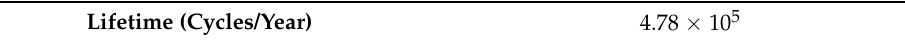
Table 13. Lifetime of LCP woven